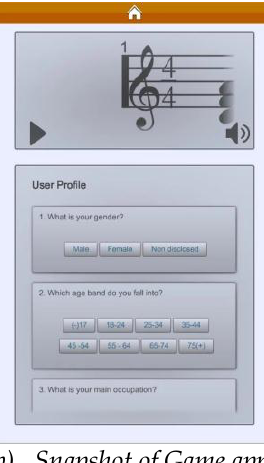
Table 1. Summary of valid number of respondents, by used survey